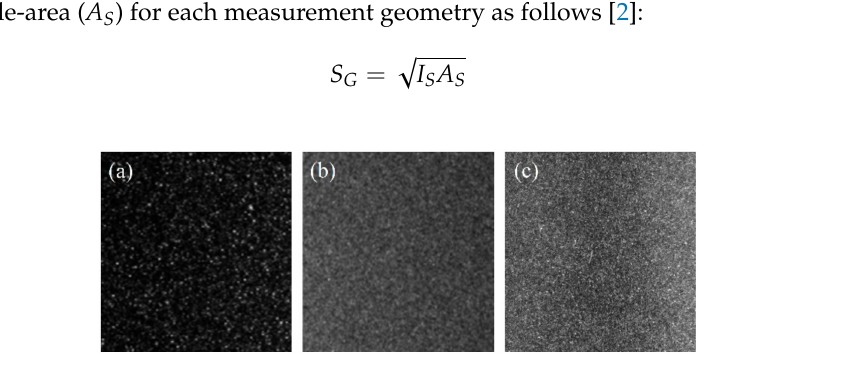
Figure 1. Illustrations of sparkle ( a ), graininess ( b ) and mottling ( c ) e ff ects of goniochromatic automotive